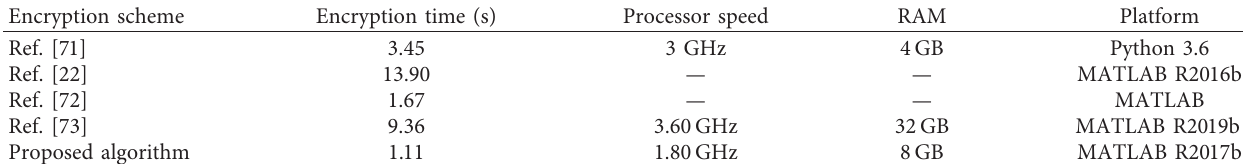
Table 11: Speed performance analysis